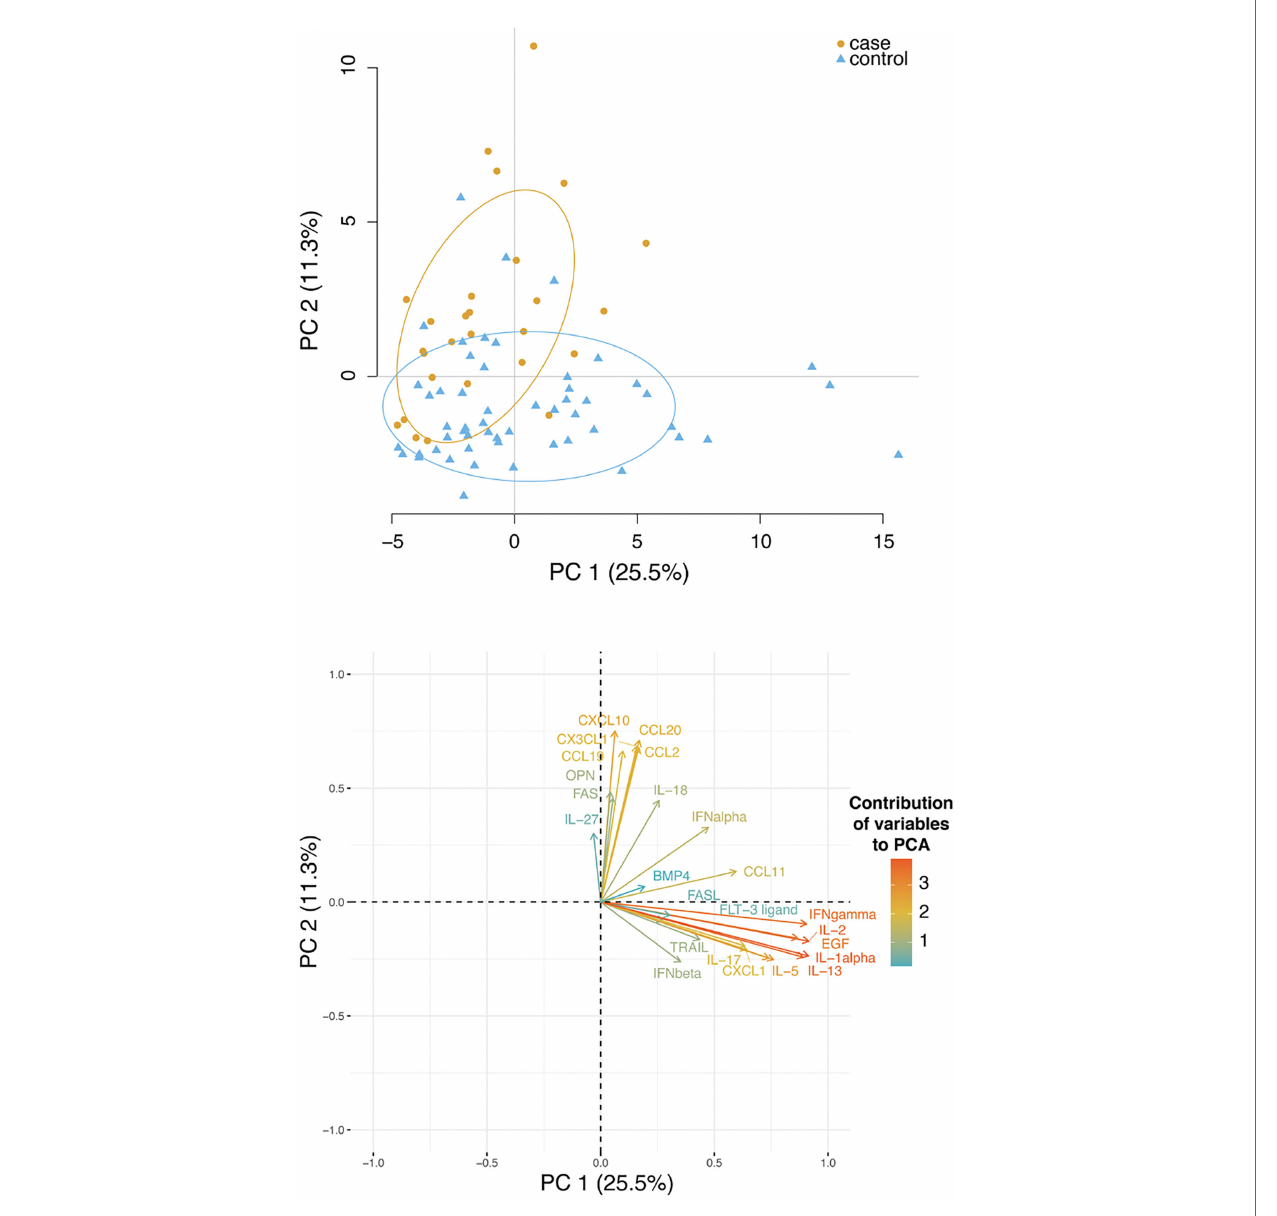
FIGURE 3 | Plasma level of several cytokines and chemokines strati fi ed controls and cases. Upper panel: principal-component analysis (PCA) analysis of cytokines, chemokines and other soluble molecules quanti fi ed across the cohort. Lower panel: a plot displays the variables as vectors, indicating the direction of each variable to the overall distribution. The strength of each variable is represented by colors: orange colour represents a strong contribution, light blue colour represents a milder